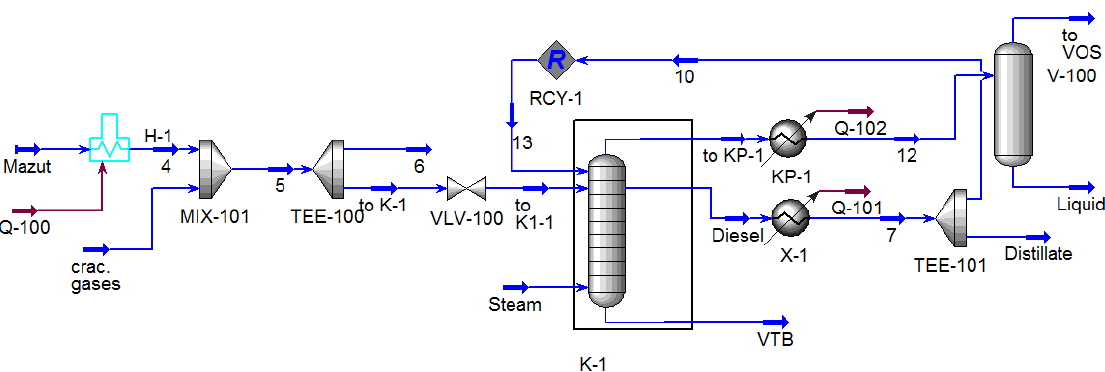
Figure 10. Design diagram of the process implemented in the Unisim Design R451 software.